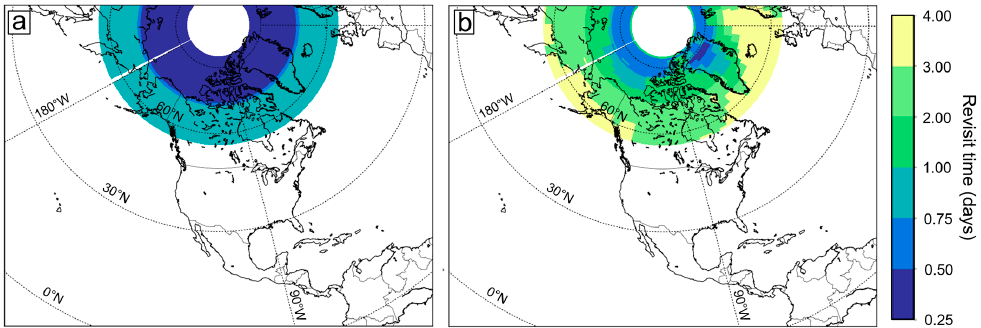
Figure 11. ( a ) Geometric revisit time and ( b ) average time in days between cloud-free revisits for PlanetScope imagery north of 55°N when satellite constellation is at full operational